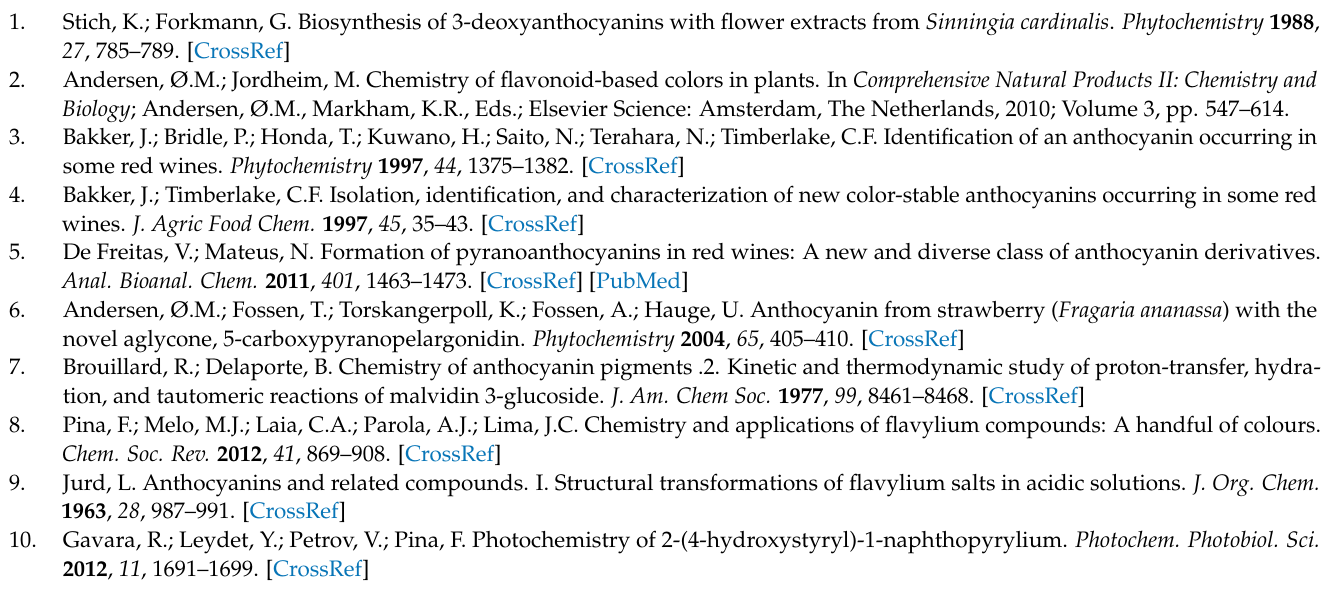
Supplementary Materials: Supplementary Table S1 : Peonidin 3- O -glucoside ( 2 ) 1 H-NMR